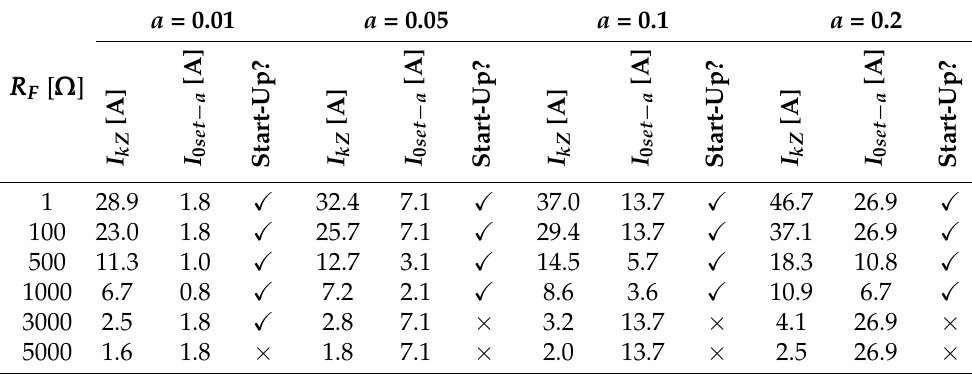
Table 6. Short-circuit current values I kZ at the FCPI installation site, adaptation criterion settings I 0 set − a and information about the start-up of the criterion in the compensated network, U n = 15 kV, I CS = 120 A, s =